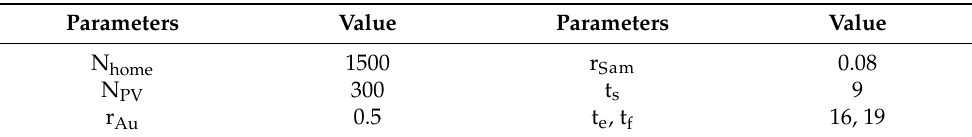
Figure 7. Geographical distribution of rooftop PV in Australia. Table 3. Parameters for case